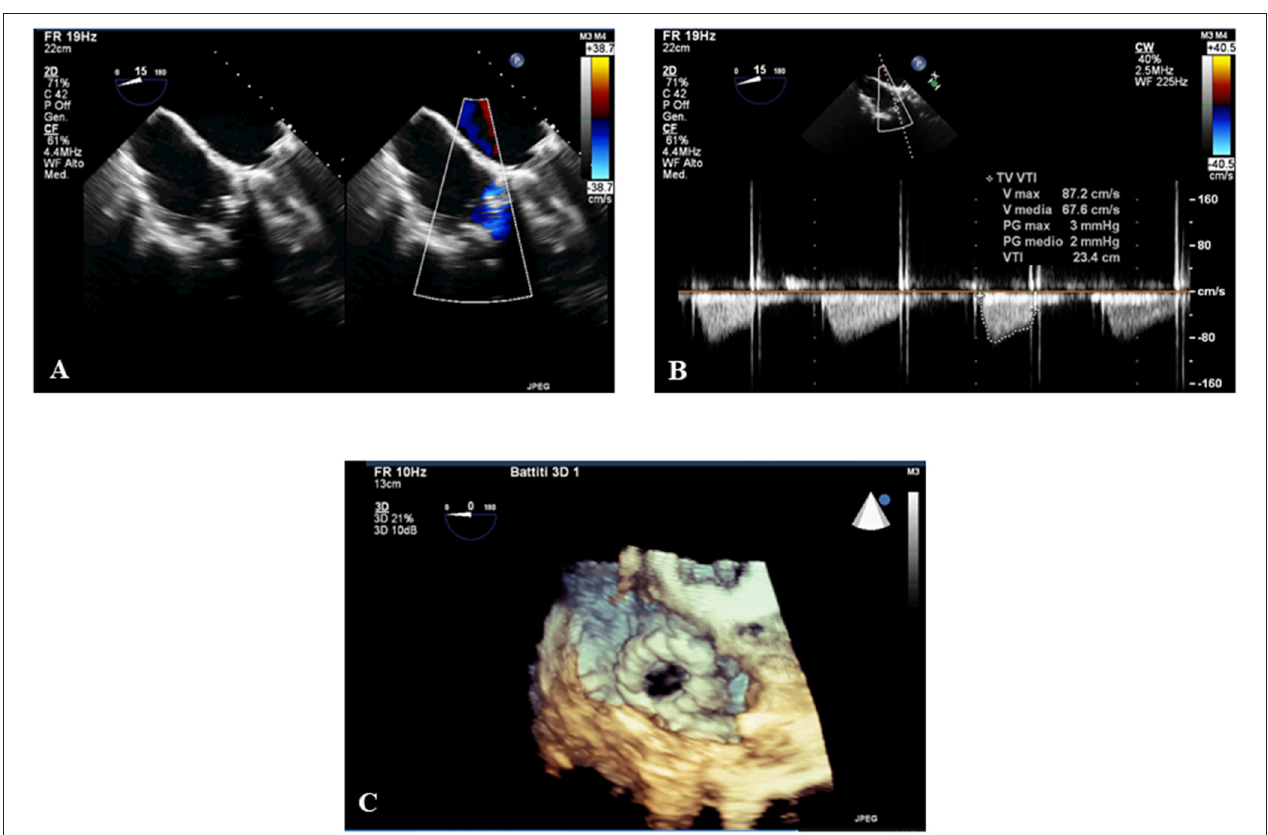
FIGURE 3 | The 3D transesophageal echocardiography (TEE) post procedure shows the normal function of the tricuspid valve. The 3DTEE post procedure shows the absence of regurgitation (A) , stenosis (B) , and the 3D reconstruction (C) of the tricuspid prosthesis after the valve in valve intervention.